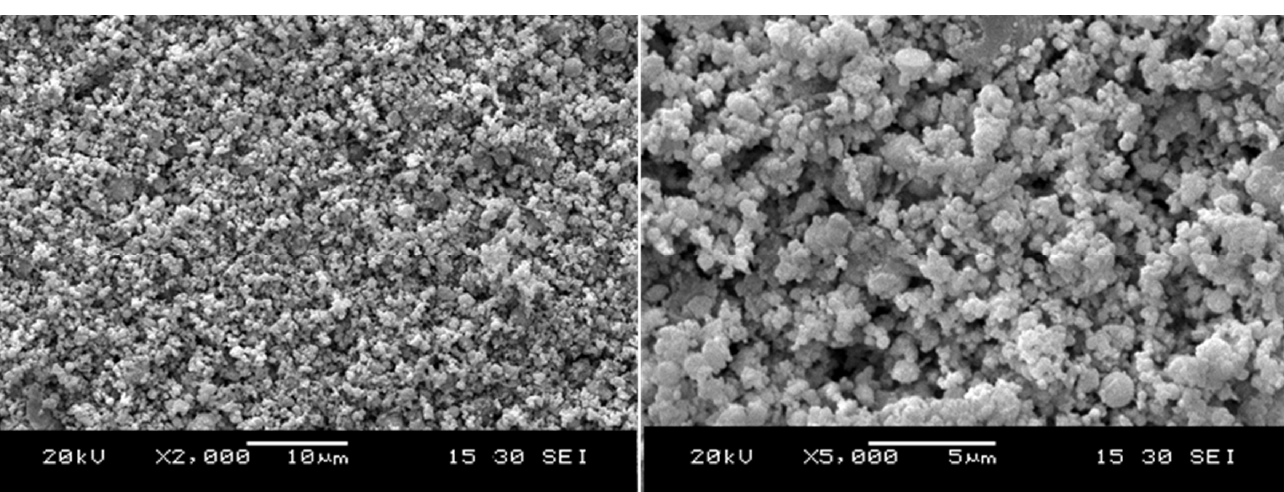
Figure 3. XRD pattern of the electric furnace flue dust.